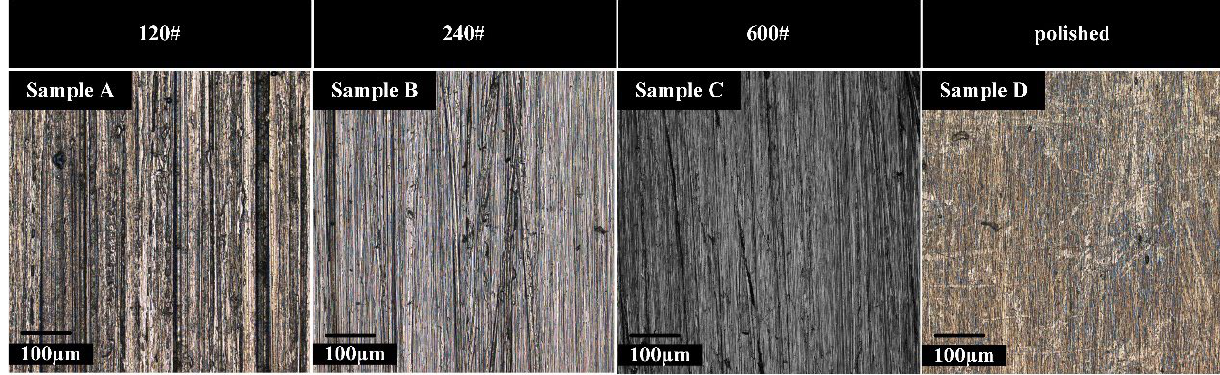
Figure 2. Surface morphologies of substrate samples: Substrate roughness of ( A ) R a 3.2, ( B ) R a 1.6, ( C ) R a 0.8, and ( D ) R a 0.2.